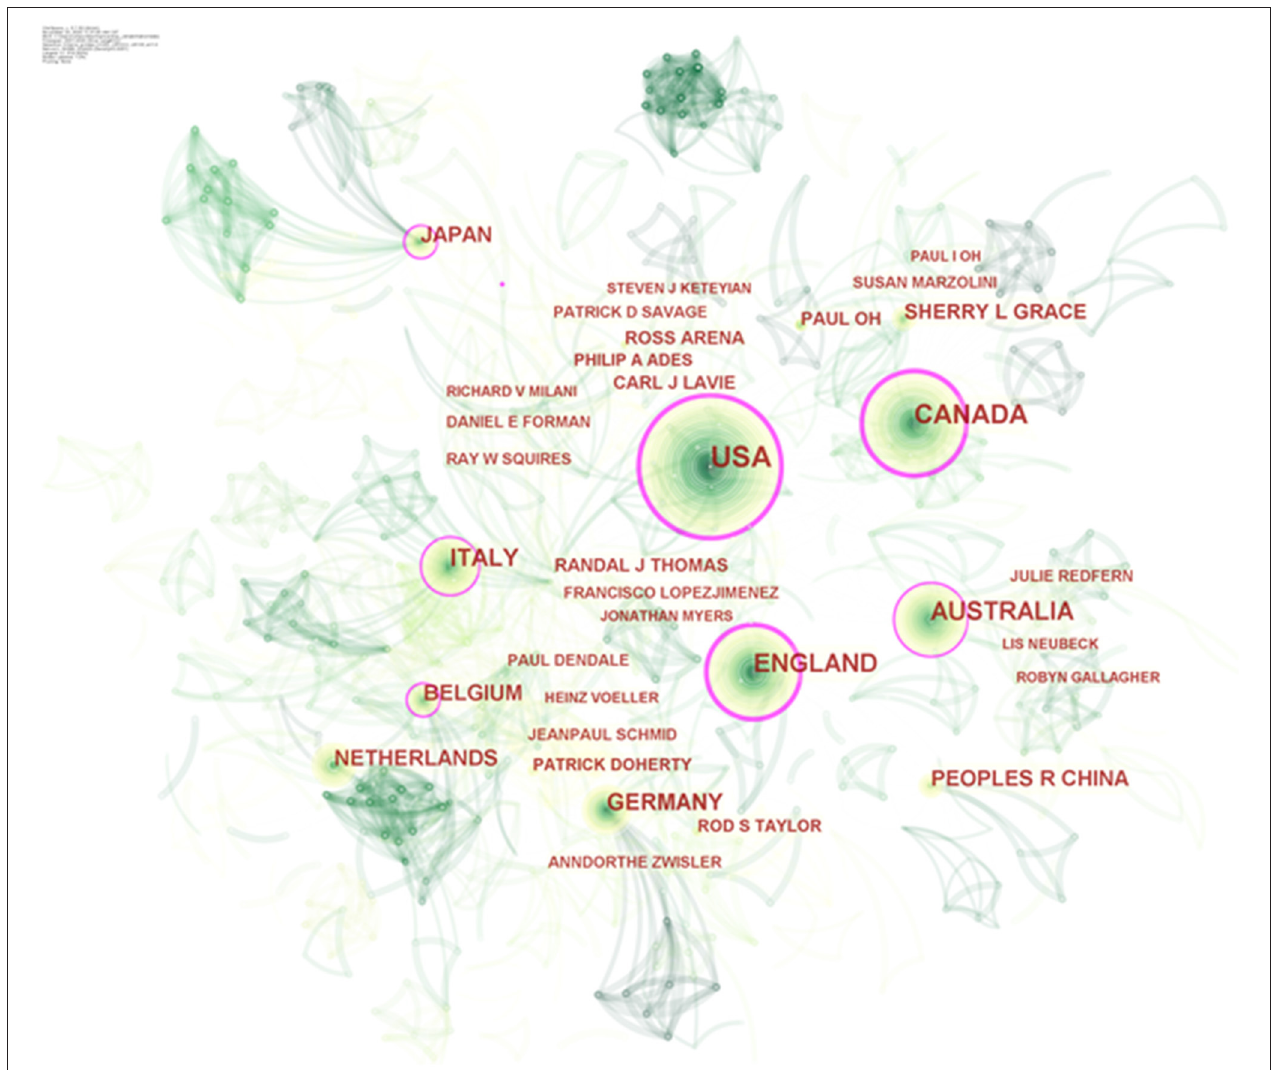
there are far more links between the nodes representing